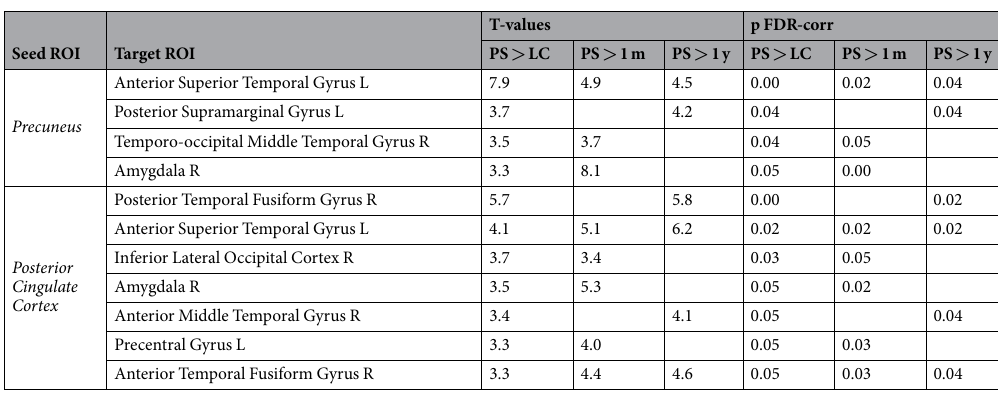
Table 3. Seed-to-target changes in connectivity over time. PS = presurgery. 1 m = 1-month follow-up. 1 y = 1-year